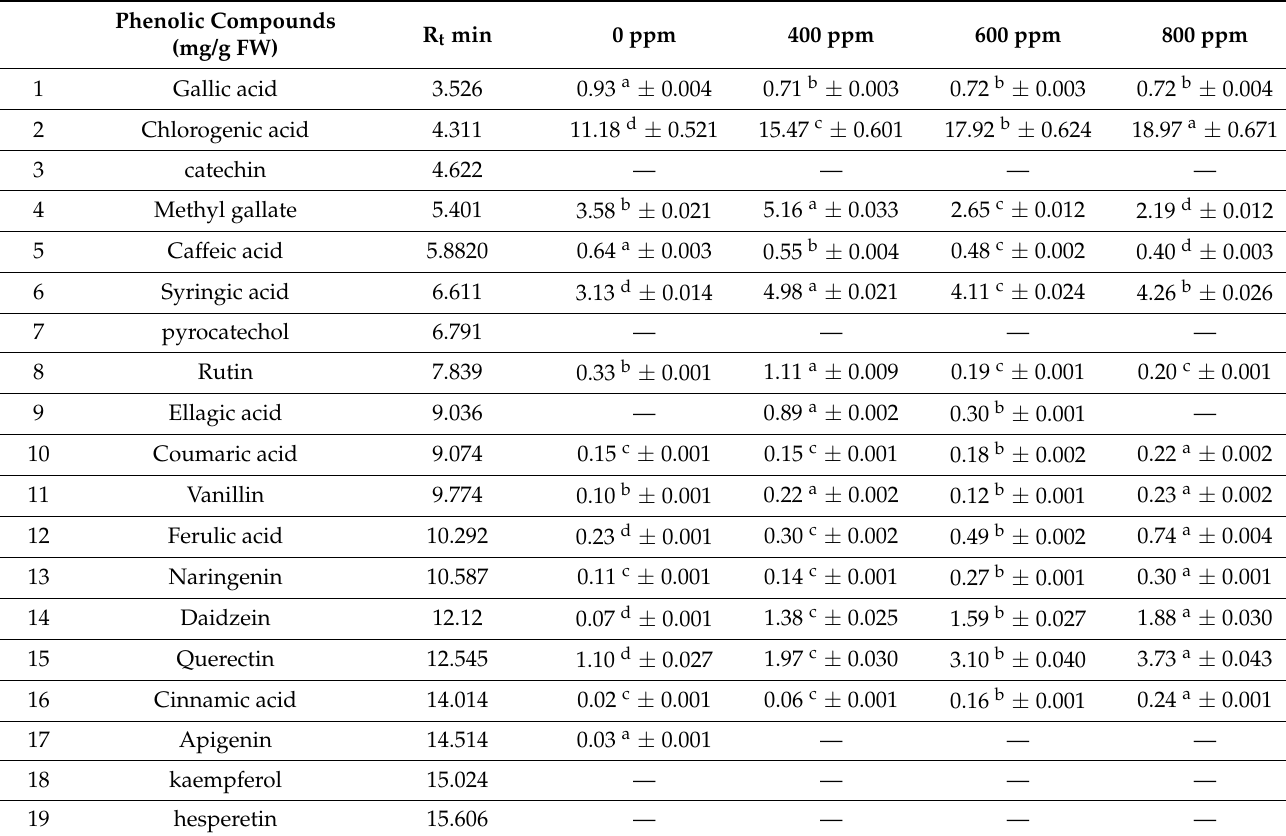
Table 4. HPLC analysis of phenolic compounds in Catharanthus roseus leaves treated with κ